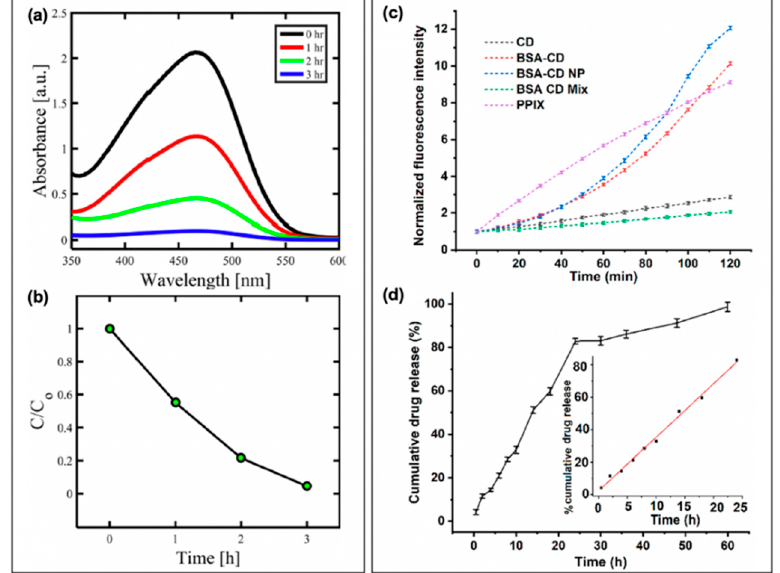
Figure 11. Considerations for maximizing the antibacterial effects for co-administration of carbon nanodots with small molecules. Examples include ( a , b ) dyes and ( c , d ) antibiotics. ( a ) Absorption spectra of methyl orange (MO) dye after irradiation of carbon nanodot treated solutions containing H 2 O 2 . ( b ) Photodegradation of MO dye. ( c ) Time-dependent reactive oxygen species (ROS) generation, detected by fluorescence-on probe Dihydrorhodamine 123. ROS generation is reported from carbon nanodots (CD), BSA-functionalized carbon nanodots (BSA-CD), nanoparticle structures (BSA-CD NP), BSA mixed with CDs (BSA CD mix), and a control photosensitizer, protoporphyrin IX (PpIX). ( d ) Time-dependent in vitro drug release of ciprofloxacin from BSA-CD NPs. For additional details regarding the reported studies, the reader is referred to Table 2 of the main text. Abbreviations: BSA (bovine serum albumin), NP (nanoparticle). Permissions : ( a , b ) Adapted from Reference [49], open access (licensed